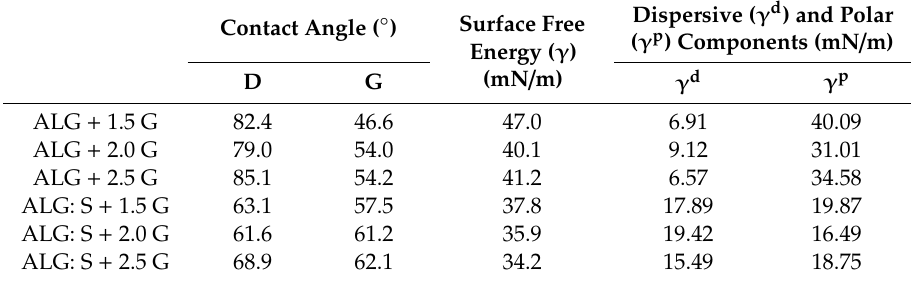
Table 4. The contact angles ( ◦ ) of diiodomethane (D) and glycerol (G), the surface free energy ( γ ), and dispersive ( γ d ) and polar components ( γ p ) values for sodium alginate-based films (calculated by Owens–Wendt method): ALG + 1.5 G, ALG + 2.0 G, ALG + 2.5 G—samples based on sodium alginate containing 1.5%, 2%, and 2.5% of glycerin, respectively. ALG: S + 1.5G, ALG: S + 2.0 G, ALG: S + 2.5 G samples based on sodium alginate and starch containing 1.5%, 2%, and 2.5% of glycerin,